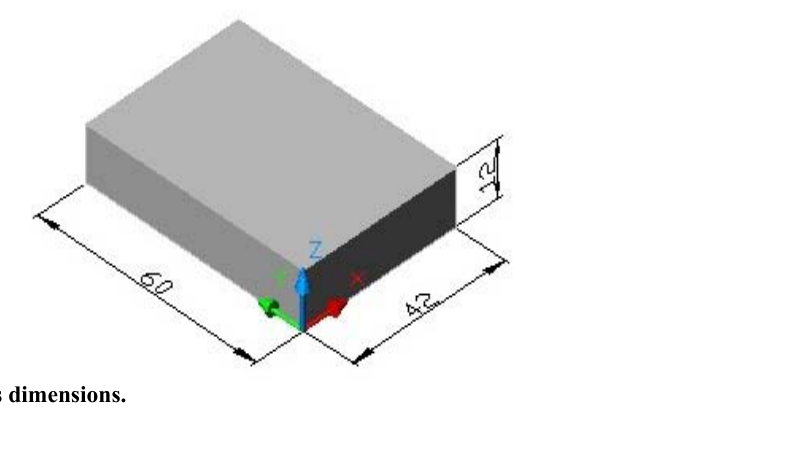
Chemical composition for Al-alloy (4032) Element Al Concentration (wt %)